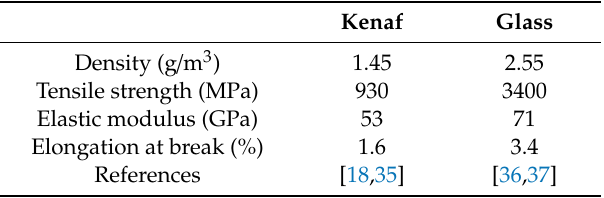
Table 3. General mechanical properties of kenaf fibre and glass